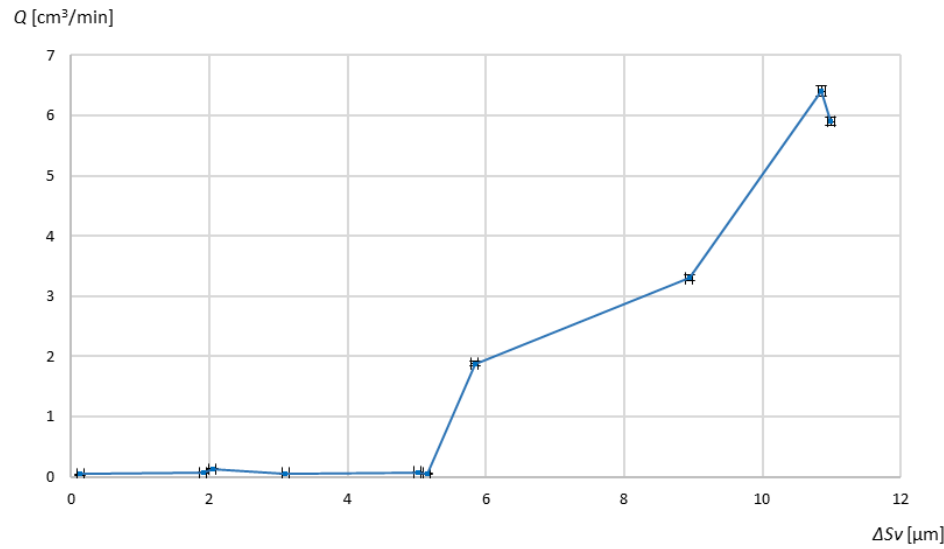
Figure 17. The value of leakage Q as a function of the difference in the value of the surface topography parameter Sv for a constant compressive force of 2280 N.